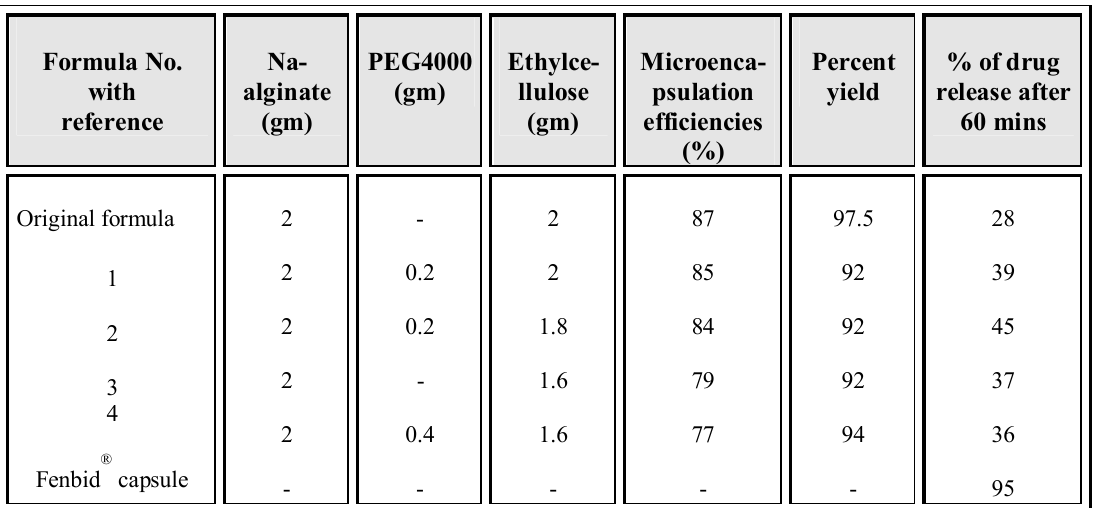
Table(3)Effect of PEG4000 Addition and Ethylcellulose on Microcapsules Properties Prepared by A Modified Organic Method ® in Comparison with Fenbid